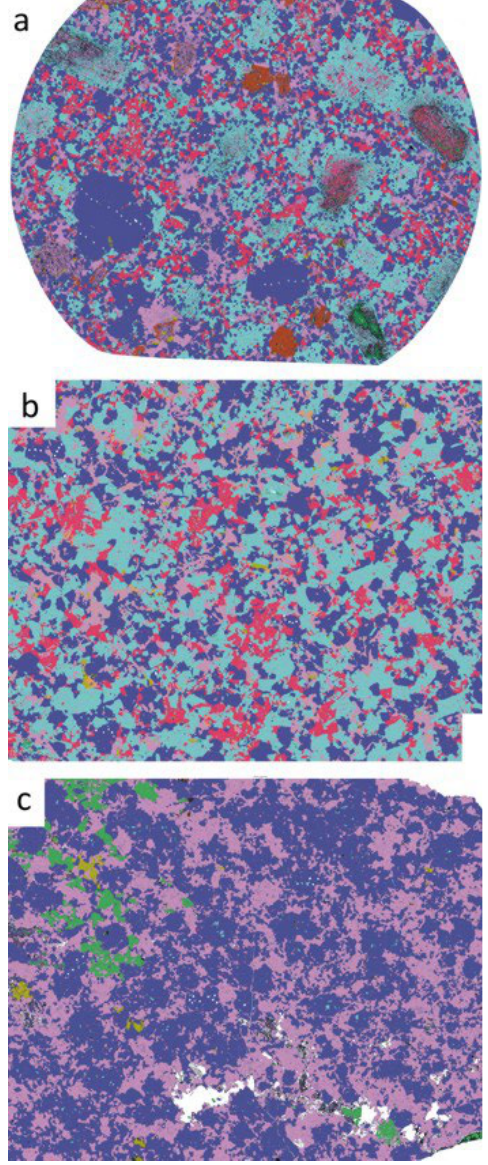
Figure 4. Textures of the main rock types visualized by automated mineralogy (TIMA): ( a ) porphyritic granite (#5); ( b ) leucogranite (#37); ( c ) greisen (#10). Width of all samples is 4 cm. Dark blue—quartz; red— K -feldspar; light blue—plagioclase; green—sulfides; yellow—apatite; brown—biotite; pink—muscovite; white—cavity.